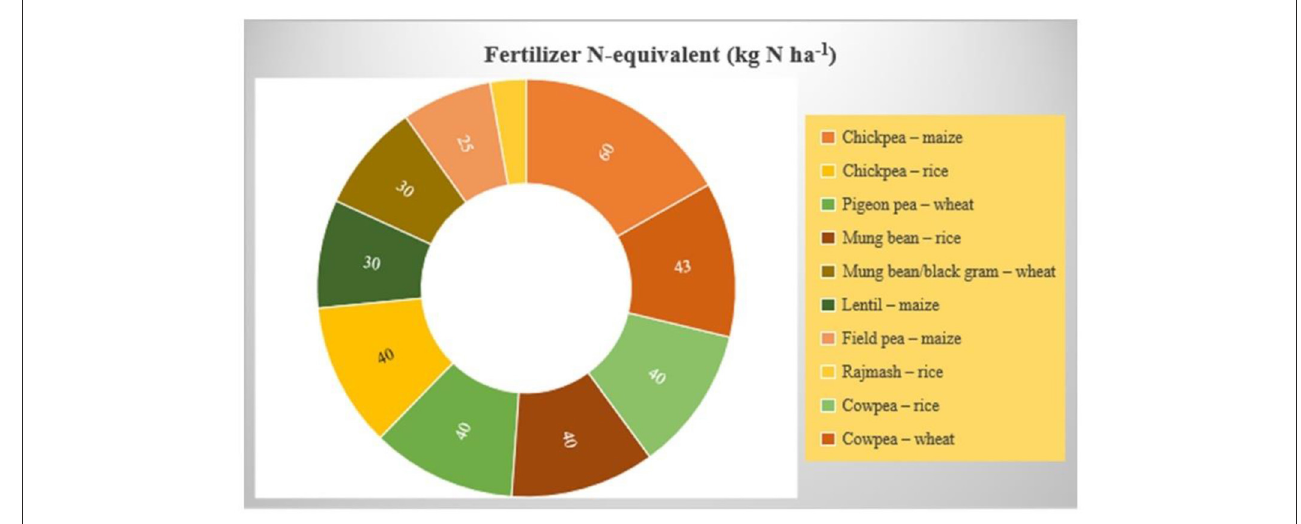
FIGURE10 Nitrogen (N) economy due to the inclusion of pulses in the cereal-based system ( Data source : Ali and Venkatesh, 2009).